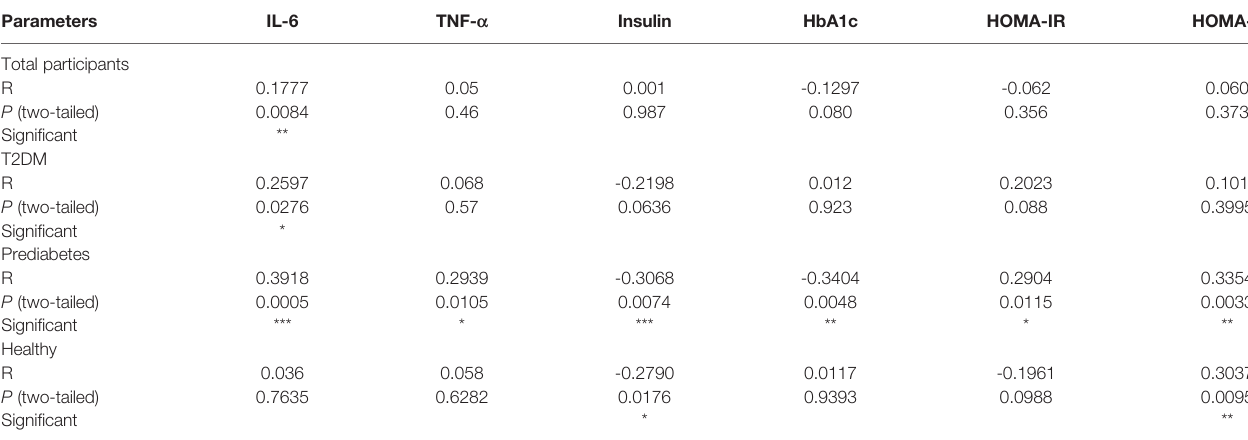
TABLE 2 | Correlations between adiponectin and other